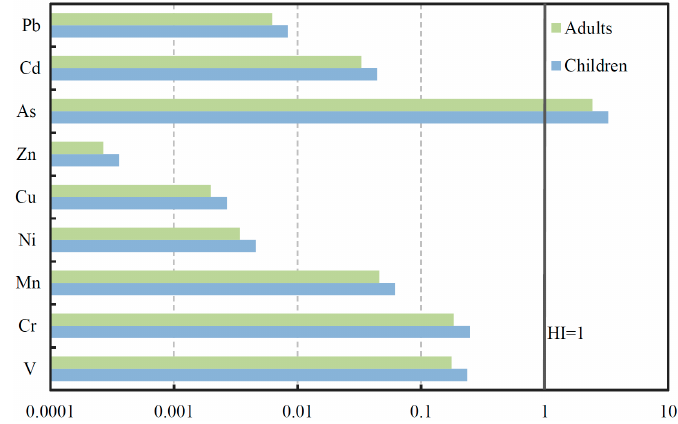
Figure 7. Hazard index (HI) for each metal(loid) of SPM in the Zhujiang River.